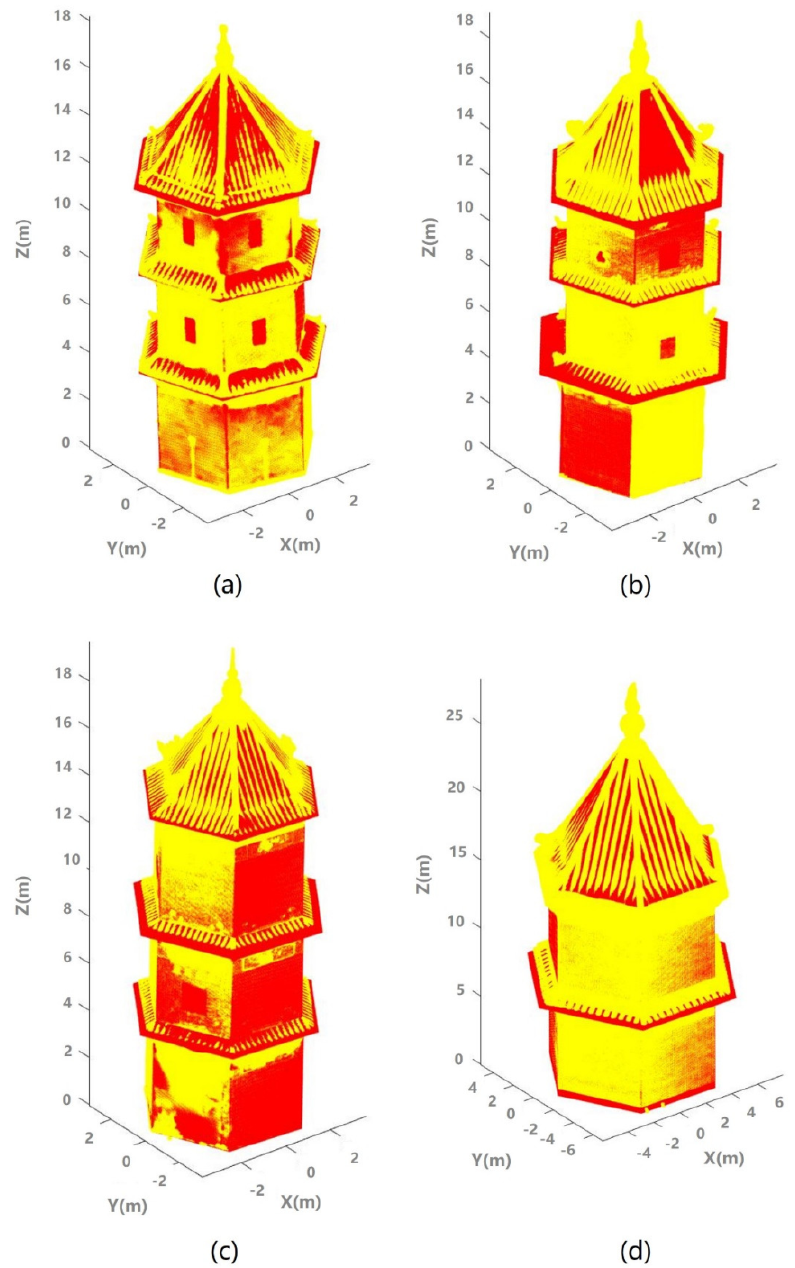
Figure 12. The best fit pagoda (red) and the original point clouds (yellow): ( a ) Pagoda A; ( b ) Pagoda B; ( c ) Pagoda C; and ( d ) Pagoda